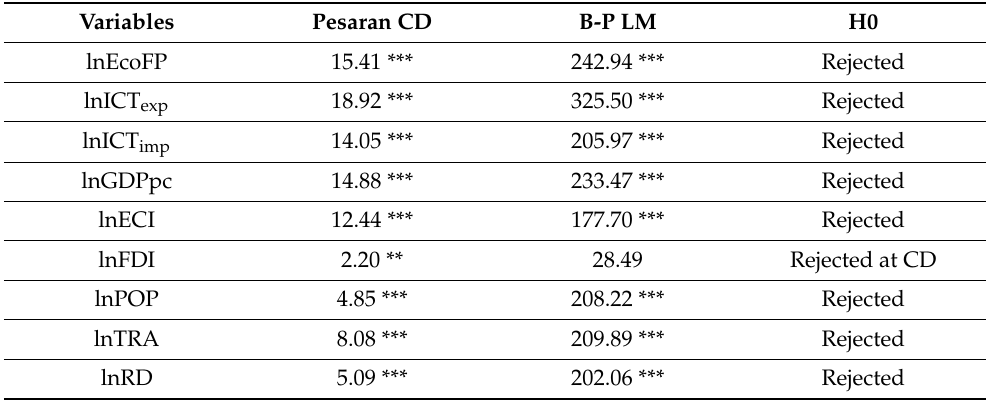
Table 3. Cross-sectional dependence.